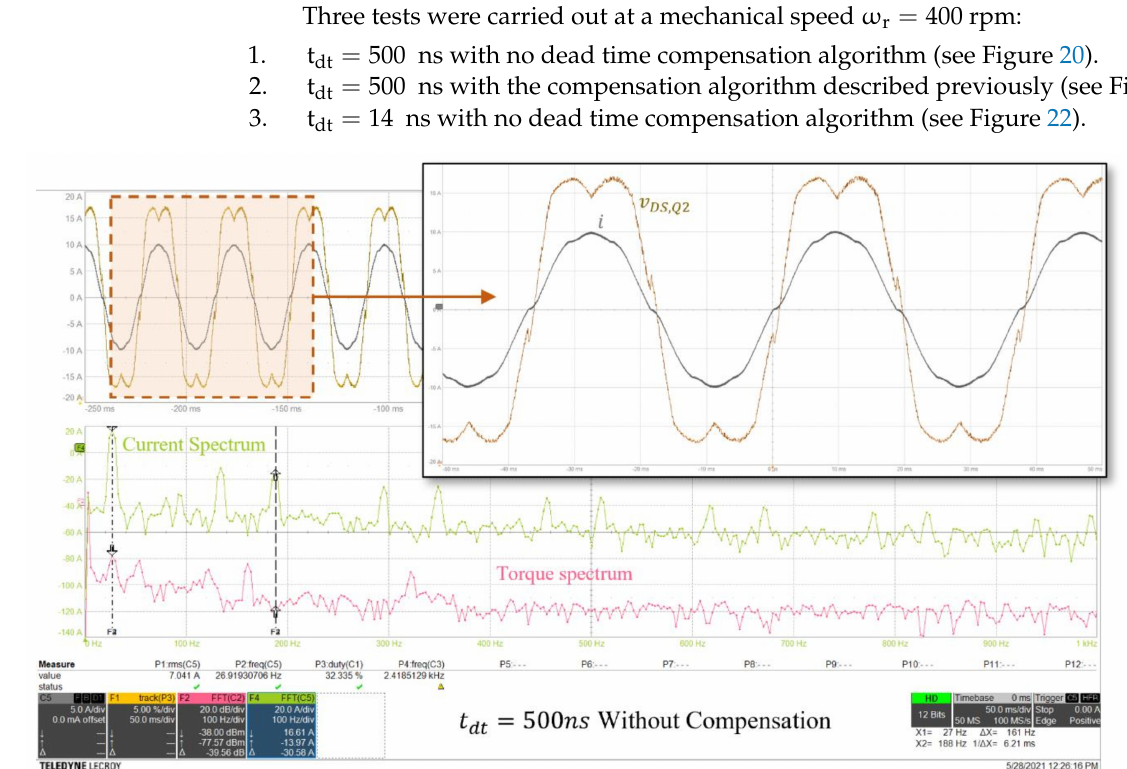
Figure 20. Motor current in the time domain and DFT of the phase current and machine mechanical torque 50 ms/div. t dt = 500 ns and no compensation algorithm. C5: motor phase current i 0 = 5 A/div. F1: reconstructed inverter voltage